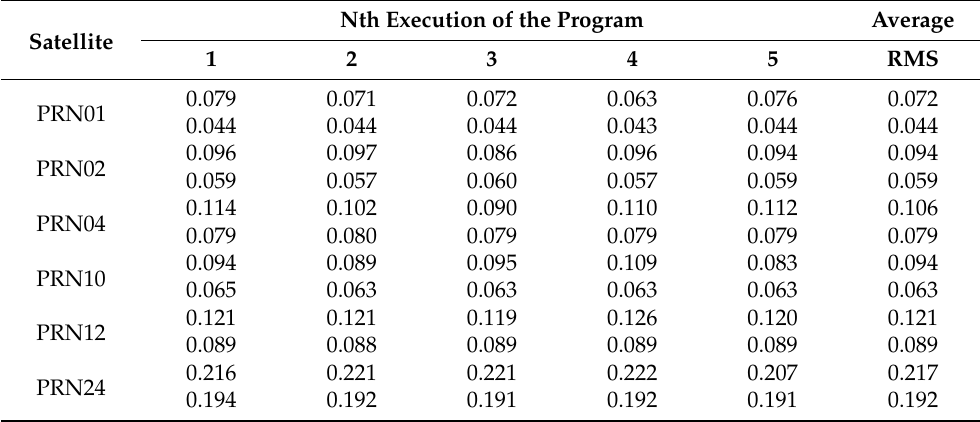
Table 4. Prediction precision of the BP model and the HPSO-BP model for five forecasts of six satellites (30-min forecasting) (Unit: